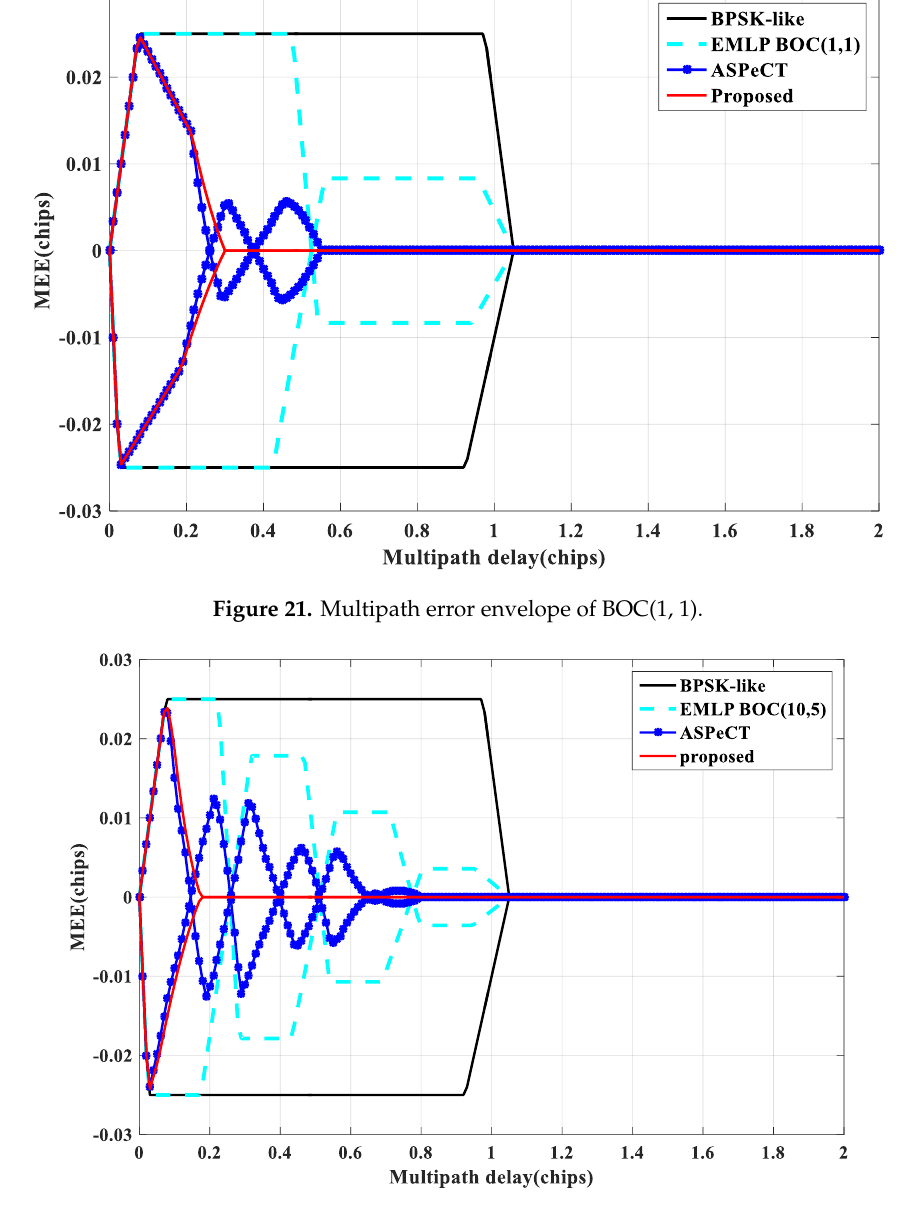
Figure 22. Multipath error envelope of BOC(10,5).